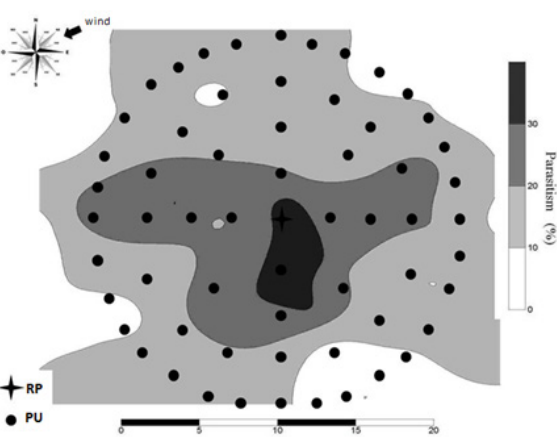
Figure 8. Spatial arrangement of parasitism units (PU), parasitoid release point (RP), wind direction (NO and 0.6 m/s) and interpolation of Trichogramma pretiosum (Hymenoptera: Trichogrammatidae) parasitism on Anagasta kuehniella eggs (Lepidoptera: Pyralidae) in cabbage